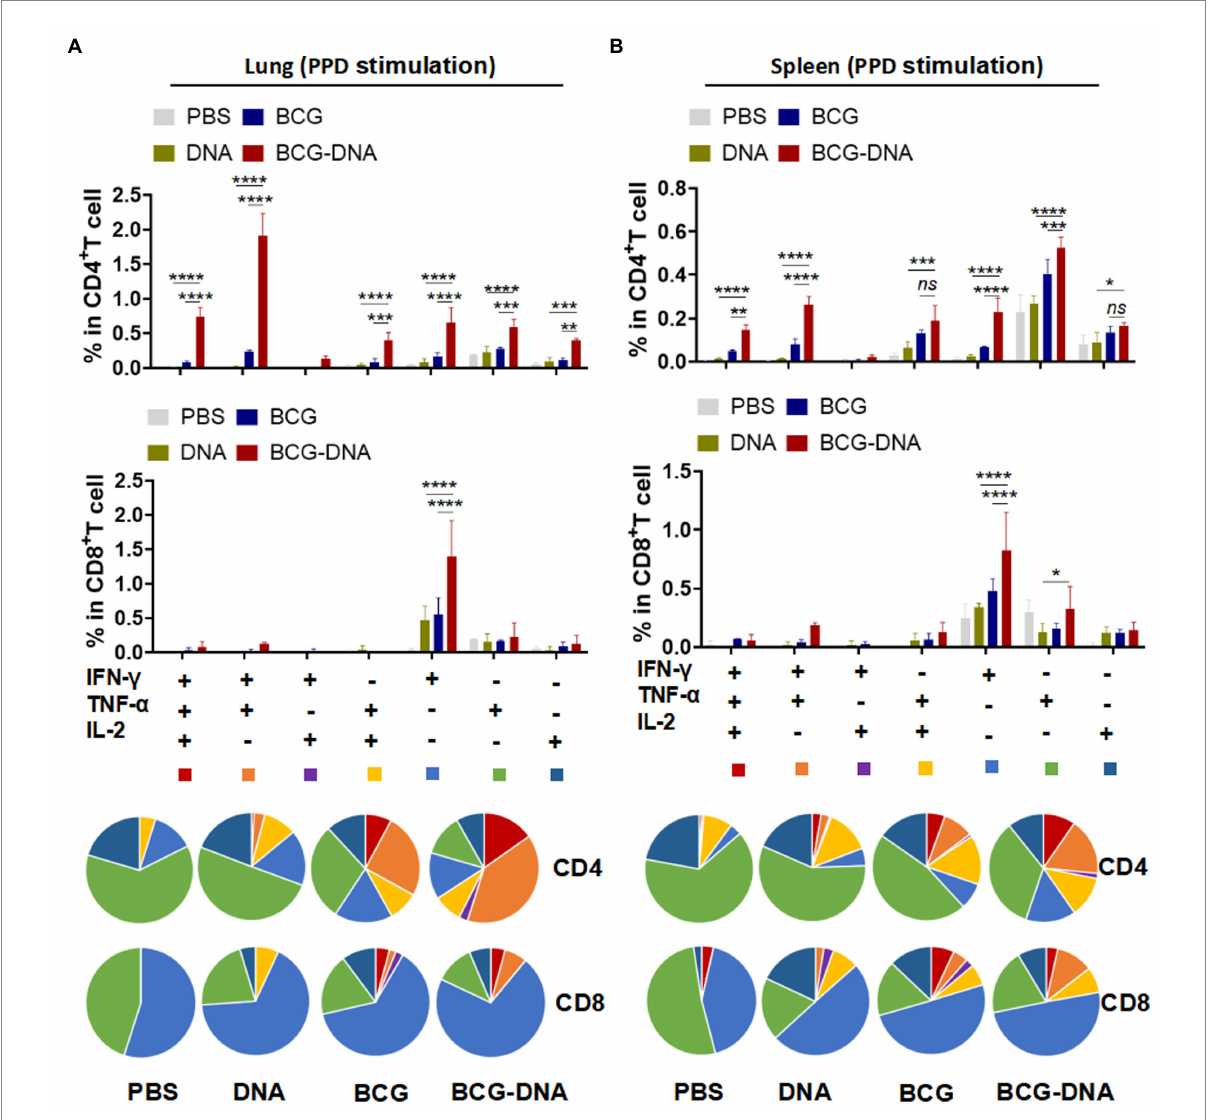
FIGURE 4 Induction of Ag-specific polyfunctional T-cells in lungs and spleens of immunized mice. Six weeks after the primary immunization, the mice were sacrificed, and their lung and spleen cells were collected and treated with PPD (10 μ g/ml) at 37 ° C for 15 h in the presence of GolgiStop. Ag-specific T cells secreting IFN- γ , TNF- α and IL-2 were distinguished by flow cytometry and classed into seven sub-populations based on the production of single or multiple cytokines. The percentages of the seven sub-populations as components of the total CD4 + or CD8 + T cells in lung (A) and spleen (B) and the pie chart analysis are shown. ( n = 3 mice, two-way ANOVA, mean ± SEM). * p < 0.05, ** p < 0.01, *** p < 0.001, **** p < 0.0001: a significant difference of treatment groups from the appropriate controls (PBS group). ns , no significant